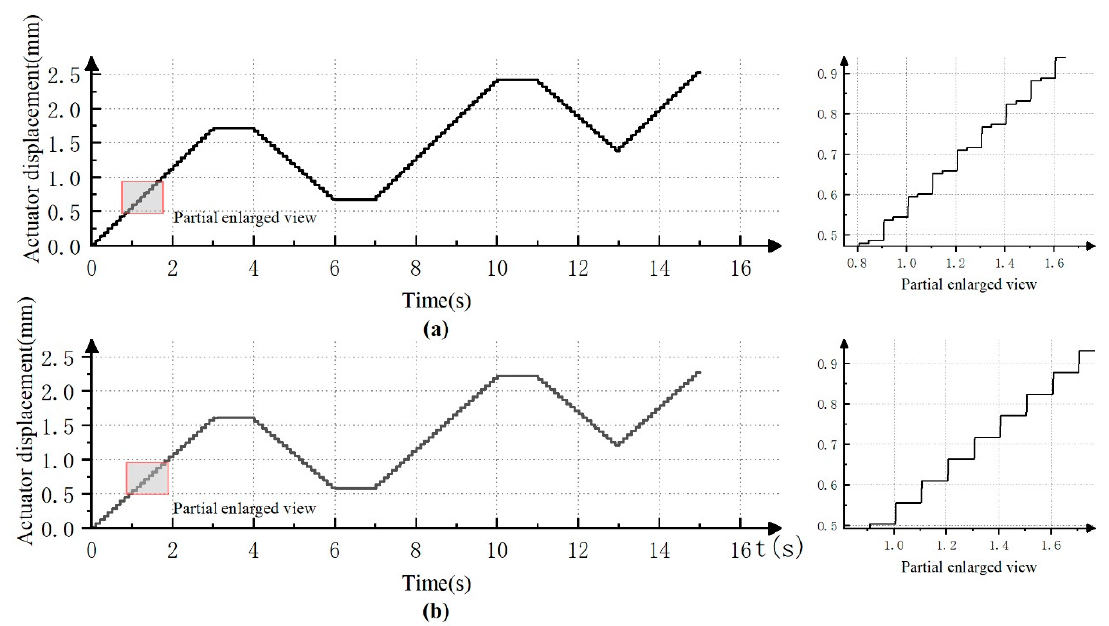
Figure 4. Simulation results of function test of hydraulic stepper drive: ( a ) the simulation result of the original stepper drive; ( b ) the simulation result of the improved stepper drive.